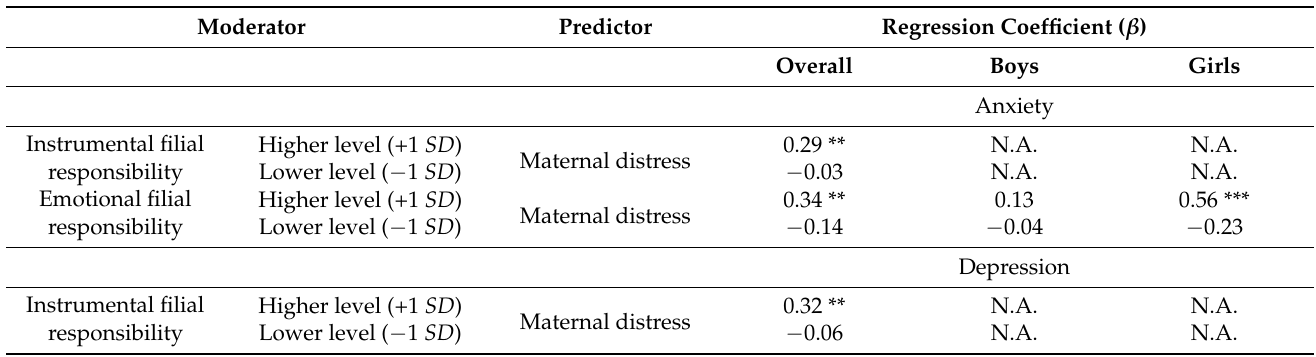
Table 3. Simple slope analyses of the relationship between maternal distress and adolescent mental health with adolescent gender and filial responsibilities as